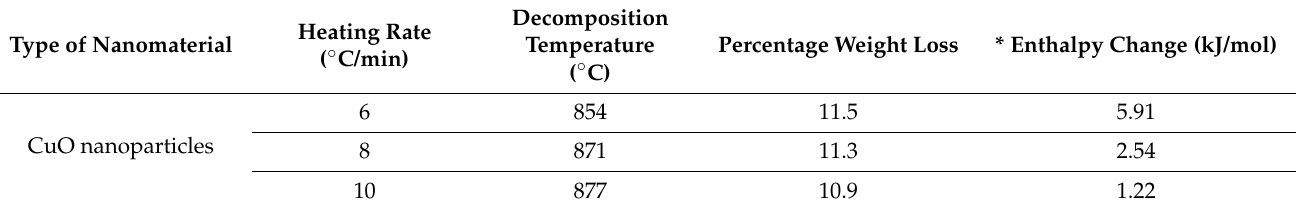
Table 2. The total weight loss, decomposition peak temperature, and enthalpy change of the CuO nanoparticles calculated using TG and DTA curves.